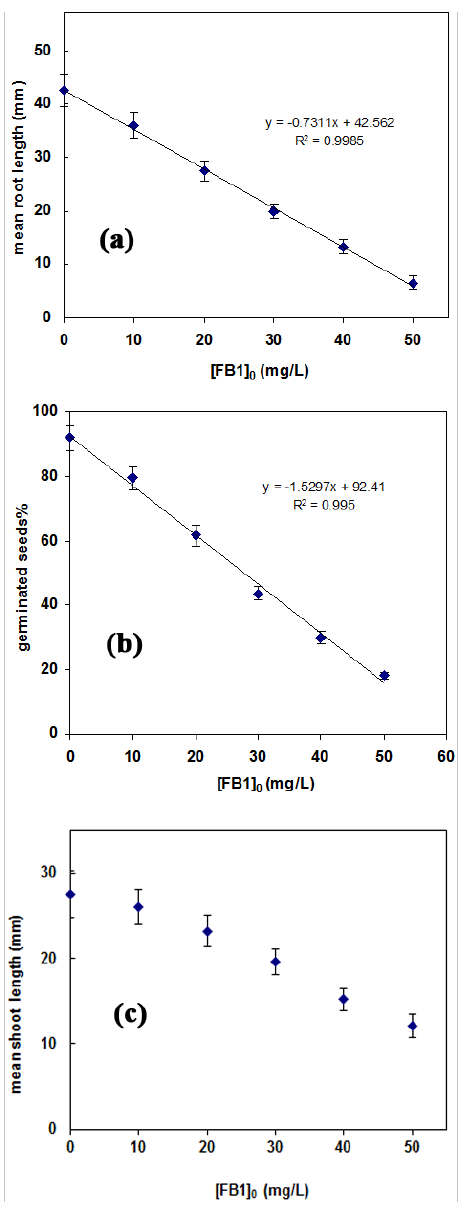
Figure 7. Influence of FB1 concentration on ( a ) root length; ( b ) germination; and ( c ) shoot length of L. sativum L.; T = 25 °C and pH = 6.7.